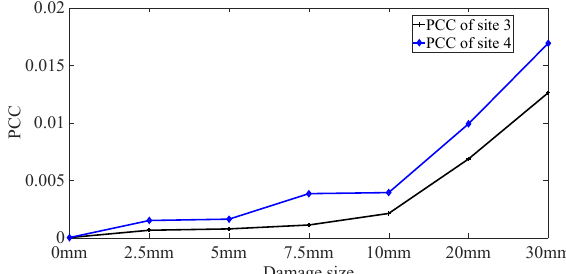
Figure 18. Damage index based on PCC of site 3 and site 4.